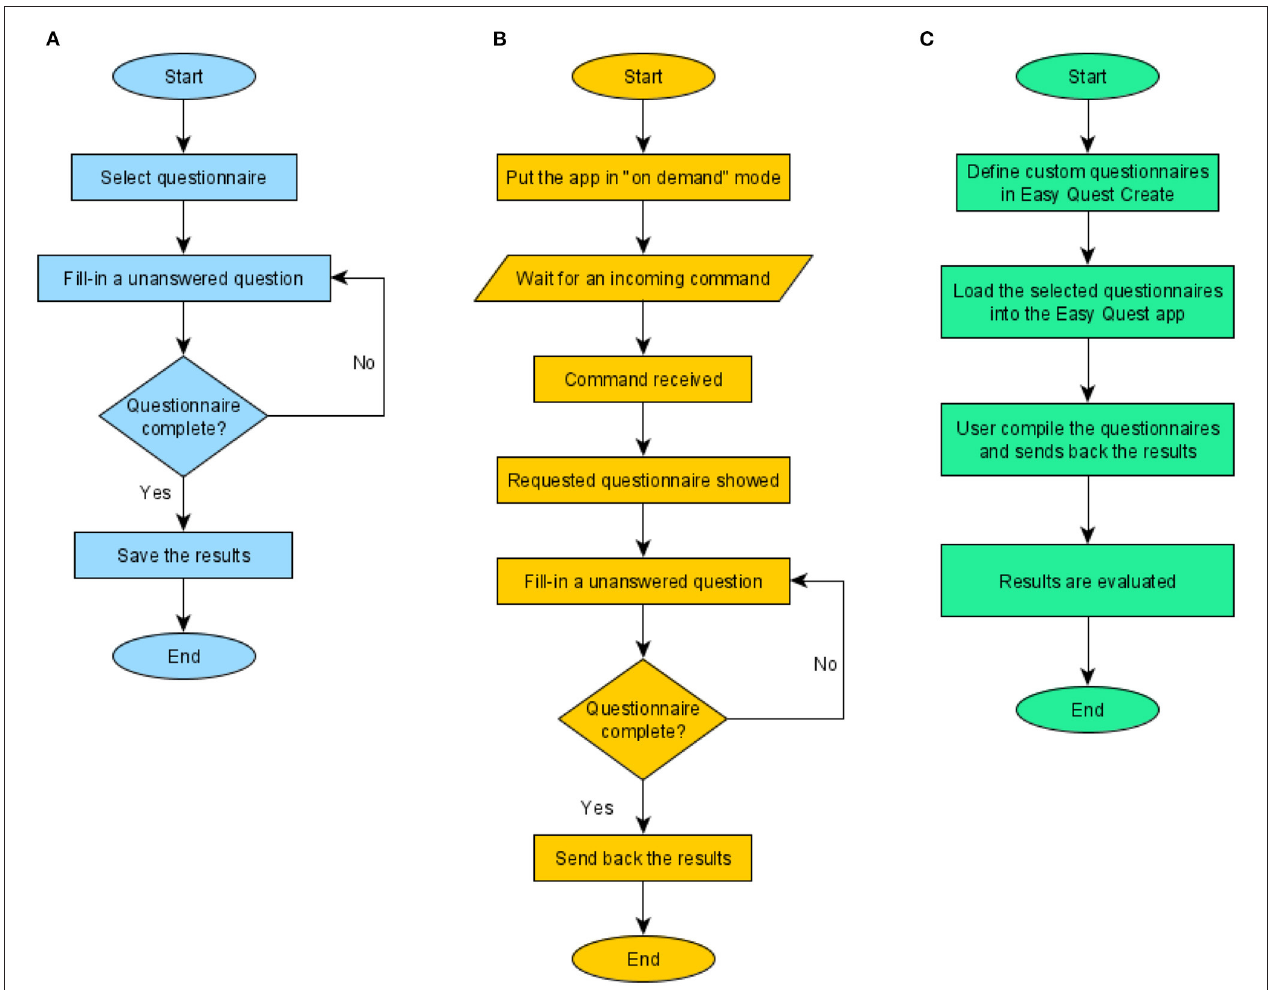
FIGURE 3 | Use cases. The three main features of the psychometric platform: the first two are implemented by the mobile app and the last by the whole system. (A) Defined as Local Fill-in (LF), where the users compile a questionnaire and the answers are stored in the device. (B) On demand fill-in (ODF), in this case, the app waits for an external command from a controller app containing information on the questionnaire to be shown; the fill-in procedure is the same but nothing is stored within the device, instead results are sent back to the controller. (C) The procedure seen from the experimenter’s point of view, here, the role of the other software programs of the platform (Easy Quest Create, Easy Quest Evaluate) is